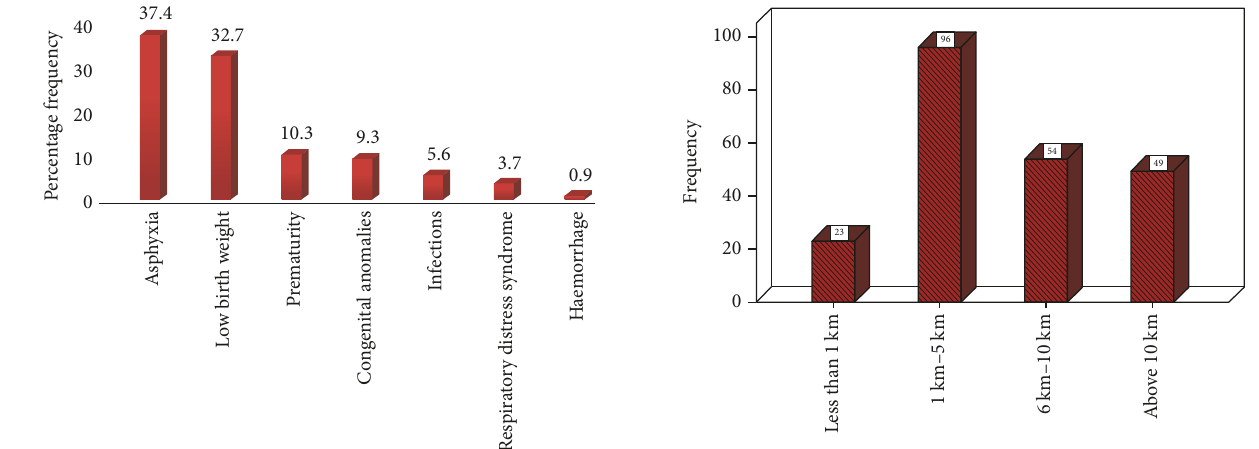
Out of 60 babies whose Apgar score was 1/10–3/10, 88.3% did not survive as compared to 77% out of 72 babies whose Apgar score was 7/10–10/10, 𝑝 = 0.038 . Regression analysis showed that babies whose Apgar score was 7/10–10/10 had 4.61 higher odds of survival (AOR = 4.61, CI = 3.02, 8.89) as compared to babies whose Apgar score was 1/10–3/10.